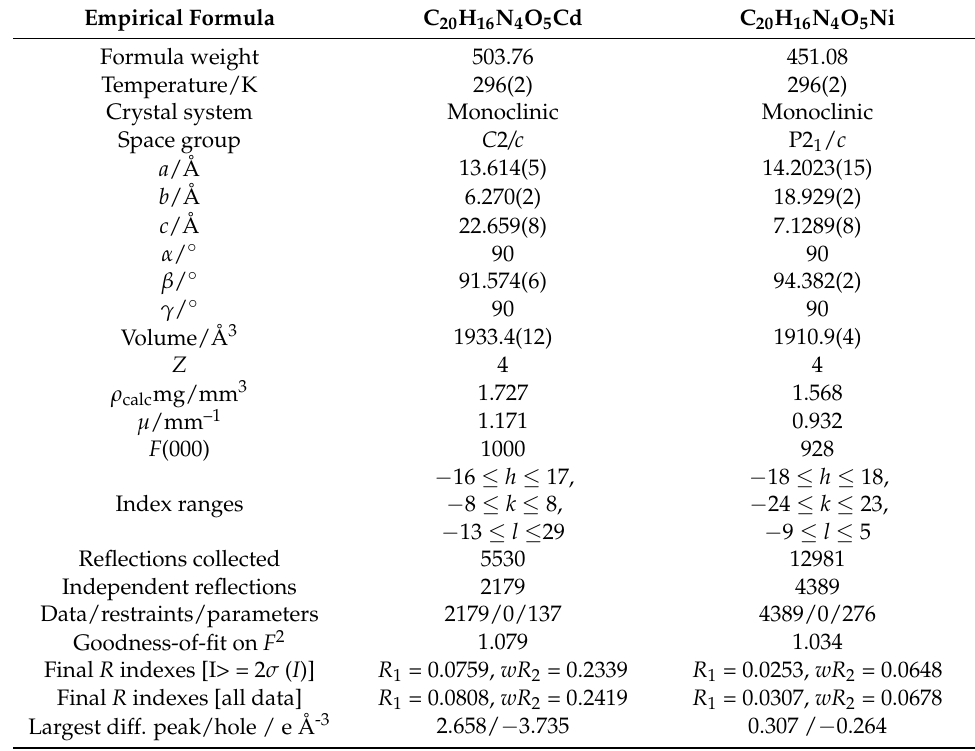
Table 3. Crystallographic data and structure refinement for 1 and 2